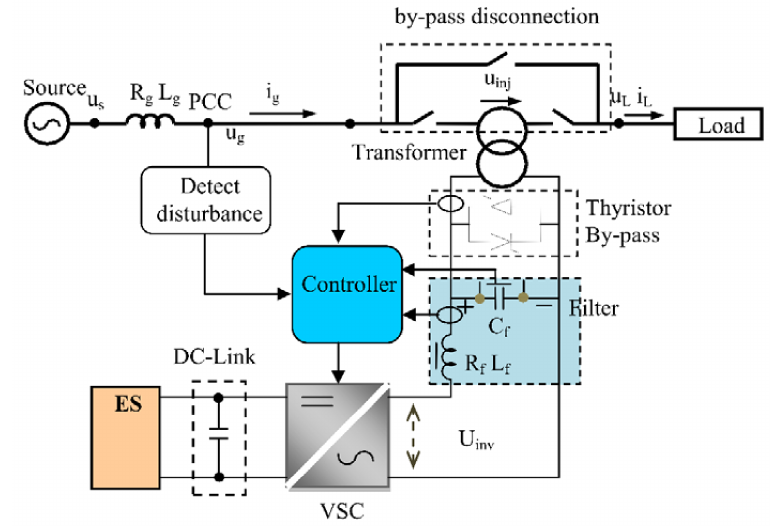
Figure 1. Configuration of DVR in the power distribution